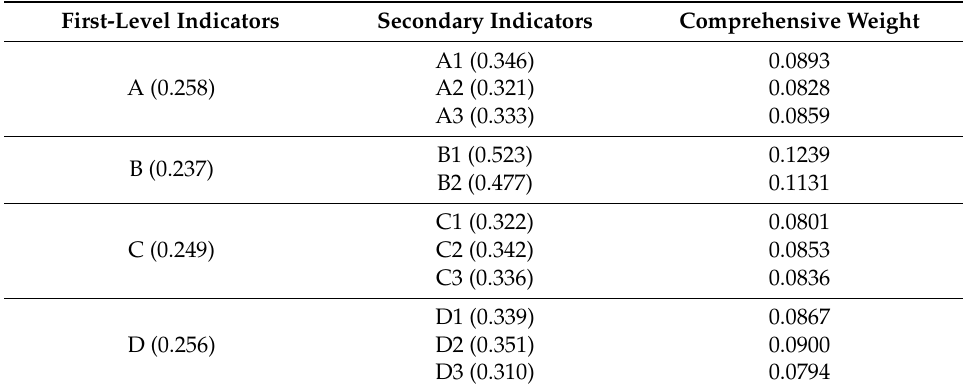
Table 13. Weights obtained by using the G1